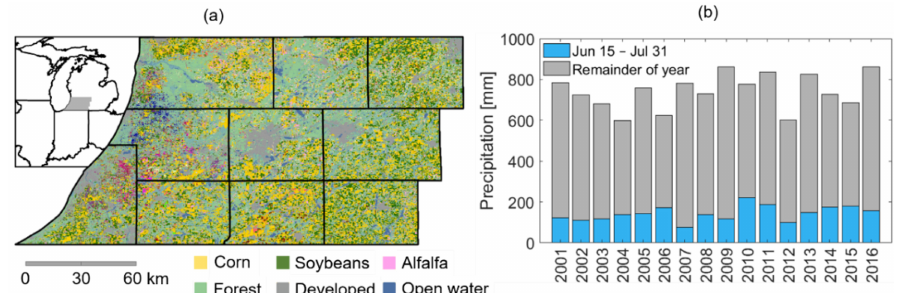
Figure 1. ( a ). The location (inset) and remotely sensed crop types (CDL, [22]) of the study area, including ten southwestern Michigan counties. ( b ) Precipitation from 15 June to 31 July (blue), and the remainder of year (gray) in the study area.